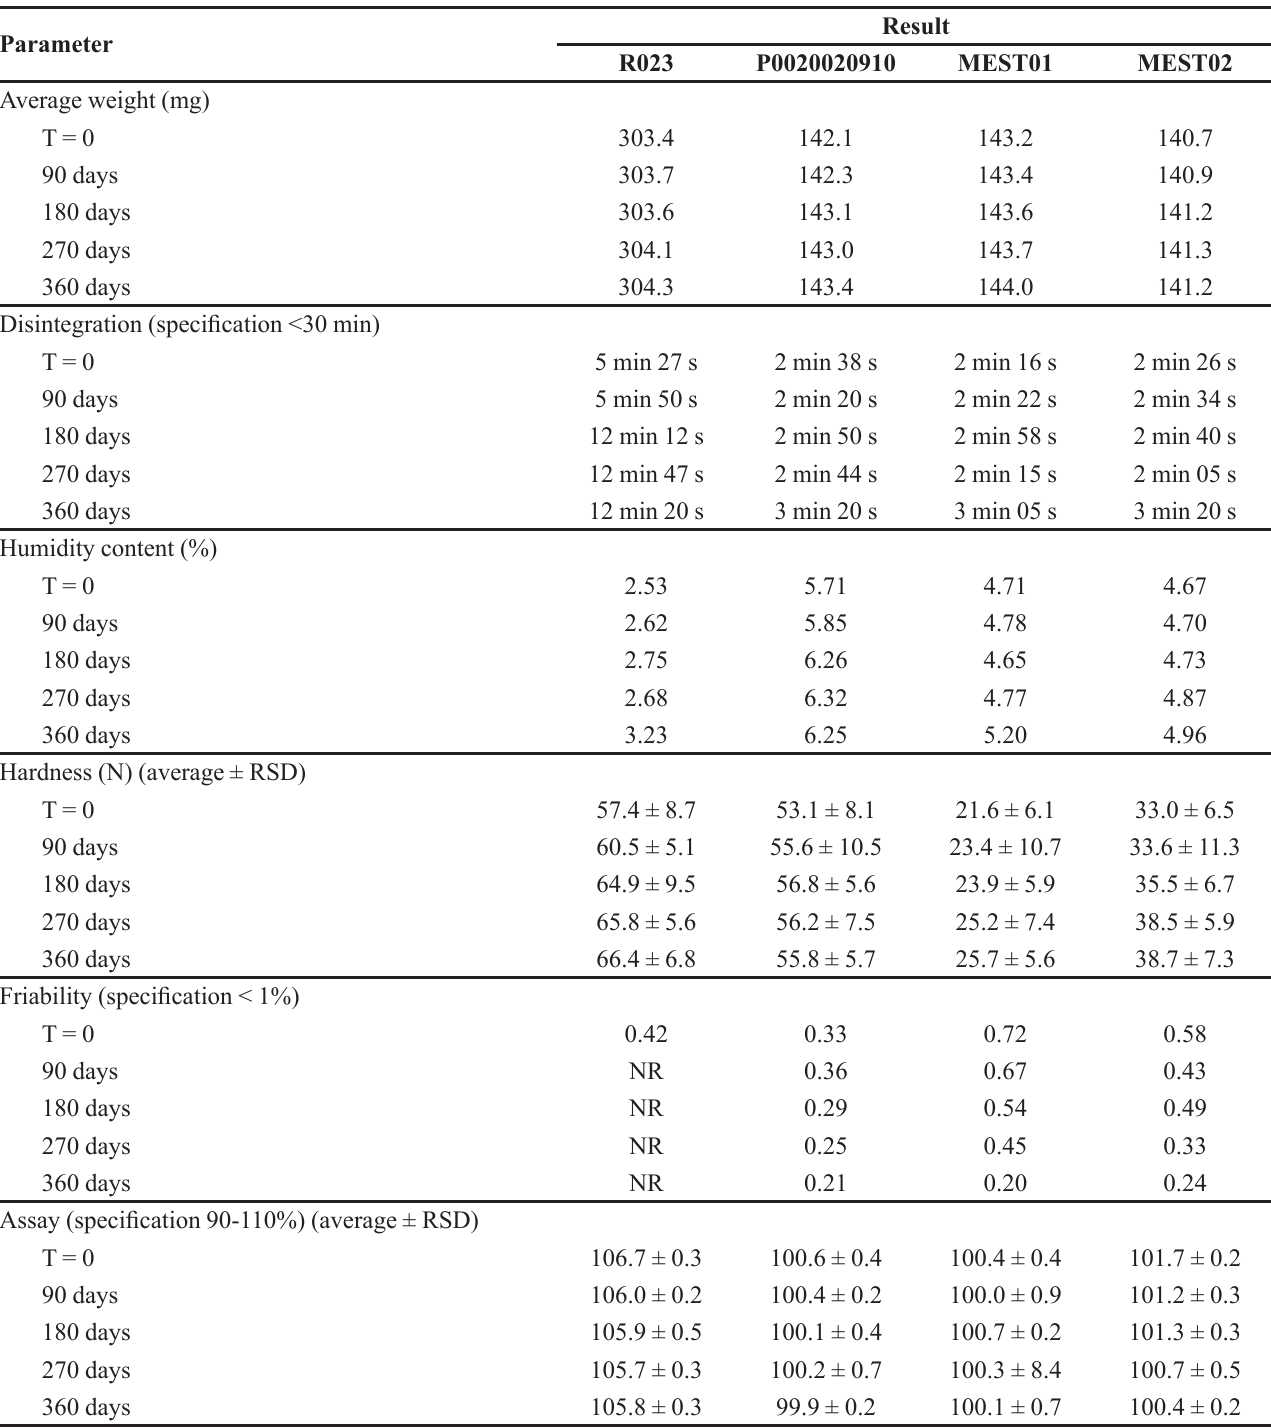
TABLE IV - Compilation of the results of pharmacopoeic parameters of the formulations evaluated during the stability study